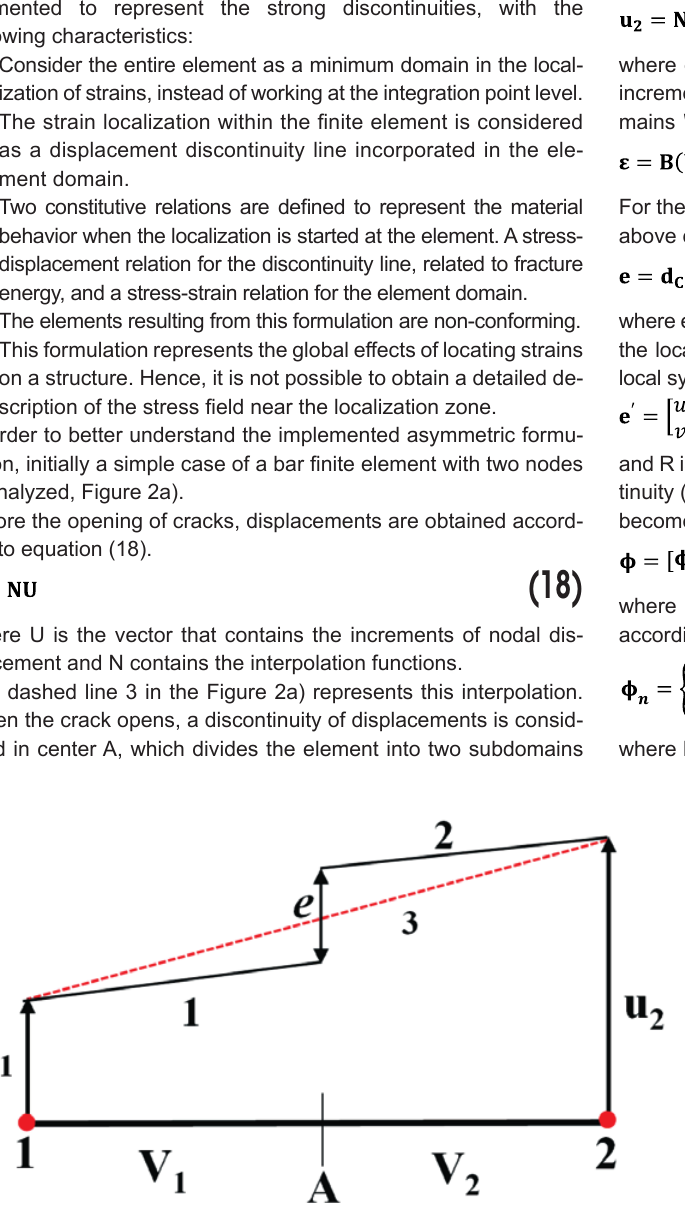
B B A Figure 2 Finite element with localization line a) one-dimensional, b) two-dimensional